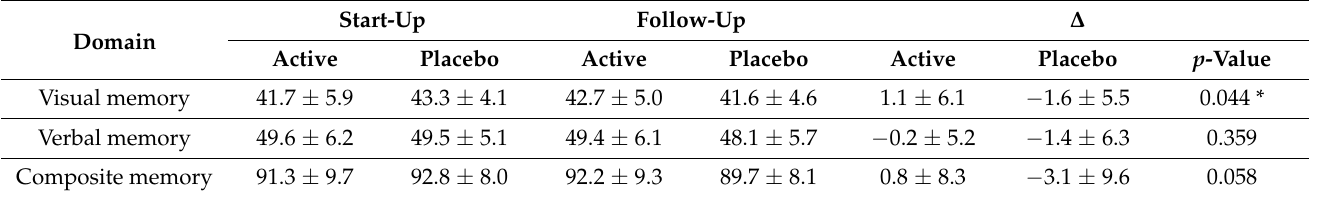
Table 2. Scores for each memory function domain in